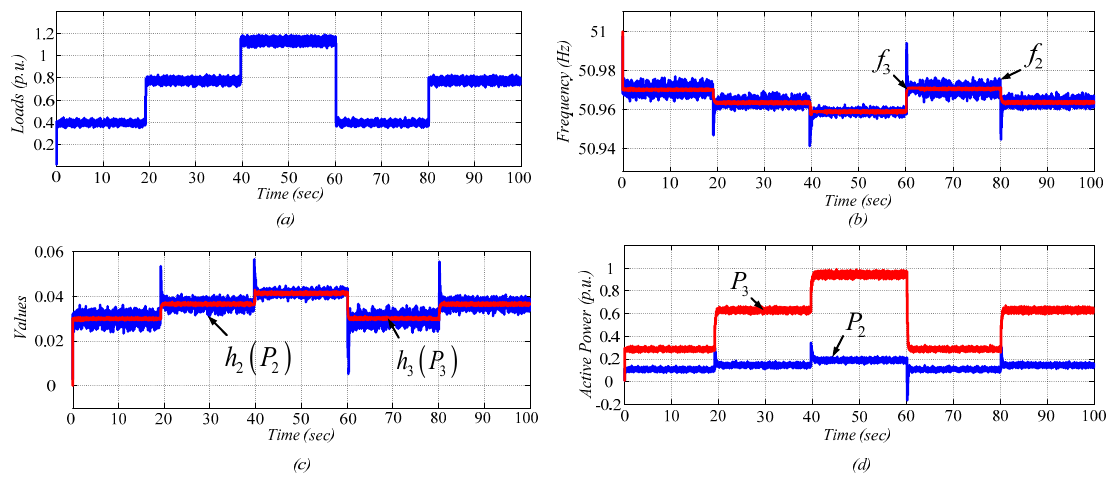
Figure 17. Variations of ( a ) loads; ( b ) frequency; ( c )  